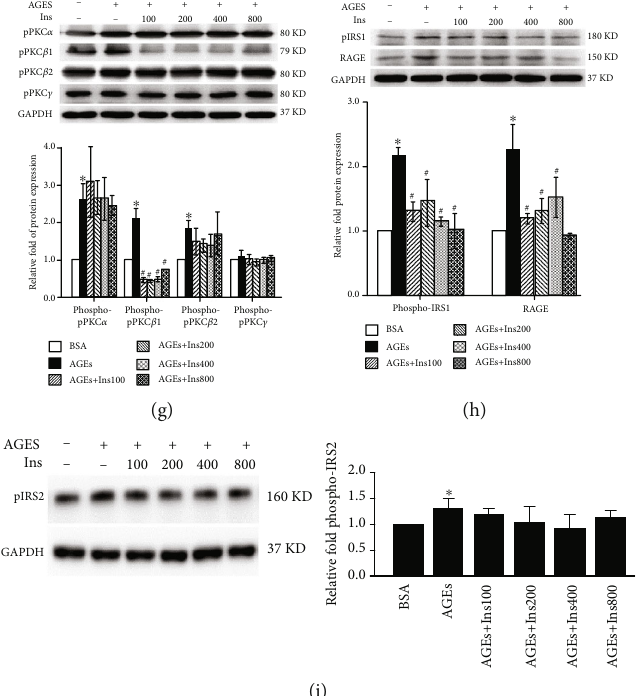
Figure 3: Insulin dose dependently attenuating AGEs-BSA-stimulated BMDCs immune maturation and decreasing expressions of RAGE and phosphorylation of PKC β 1 and IRS1. (a) Flow cytometric analysis was performed for cell surface CD83, CD86, and MHC-II expression examinations. Insulin exerted an inhibitory e ff ect on the expressions of CD83 and CD86 in a dose-dependent manner. (b) The concentrations of TNF- α , IFN- γ , IL-6, IL-1b, and CCL2 in the supernatants of the culture were measured by ELISA. (c, d) The expressions of cytokines and chemokines mRNA in BMDCs were analyzed by real-time quantitative RT-PCR. Results of (b – d) suggested insulin attenuated the expressions of AGEs-BSA-induced IL-1b, IL-10, IFN- γ , and TNF- α .; (e – i) The expressions of phosphorylated and total NF- κ B (e), phosphorylated and total I κ B (f), phosphorylation of PKC isoforms (g), serine phosphorylated IRS1 and RAGE (h), and serine phosphorylated IRS2 (i) were analyzed by western blot. I κ B and NF- κ B phosphorylation decreased signi fi cantly with the insulin treatment in a dose-dependent manner. Insulin treatment decreased signi fi cantly the upregulated expression of RAGE, phosphorylation of PKC β 1, and serine phosphorylation of IRS1, not the phosphorylation of PKC α and PKC β 2. AGEs signi fi cantly upregulated the expression of serine phosphorylated IRS2, while insulin had no signi fi cantly e ff ect on phosphorylated IRS2. Data are expressed as mean ± SED ; n = 5 ; ∗ p < 0 : 05 vs. control group; # p < 0 : 05 vs. AGEs-BSA group. AGEs-BSA: advanced glycosylation end-bovine serum albumin; BMDCs: bone marrow-derived dendritic cells; RAGE: receptor for advanced glycation end products; pPKC: phosphorylated protein kinase C; IRS1: insulin receptor subunit-1; IRS2: insulin receptor subunit-2; TNF- α : tumor necrosis factor- α ; IFN- γ : interferon- γ ; MHC-II: major histocompatibility complex-II; NF- κ B: nuclear factor- κ